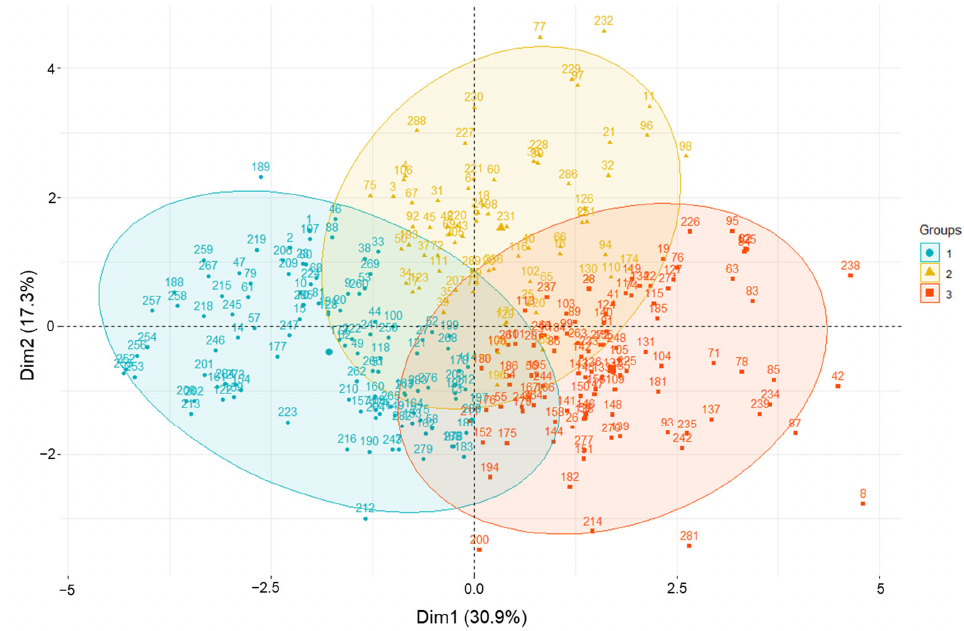
Figure 4. Principal component analysis biplot showing amaranth genetic resource clustering based on agricultural traits, phytochemical content, and antioxidant activities using the whole dataset.